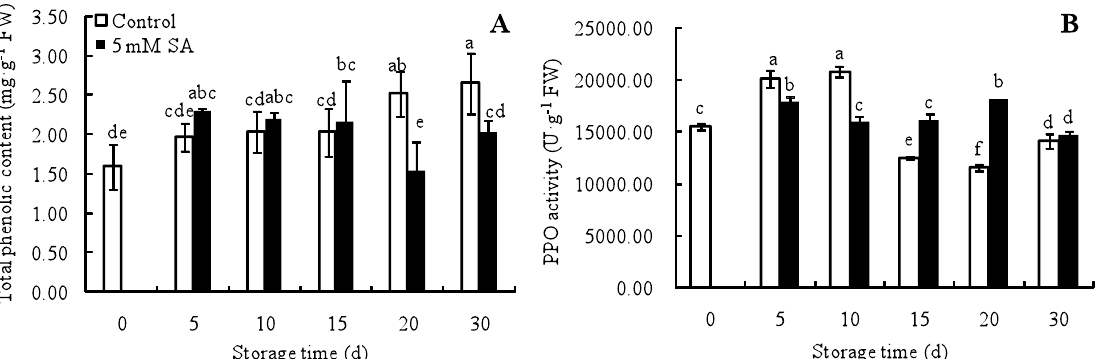
Fig. 4: Changes of total phenolic content (A), PPO activity (B) of peel in ‘Huangguan’ pear by SA treatment during cold storage. Values are mean ± SE of three replicates. Different letters represent significant differences at P = 0.05.